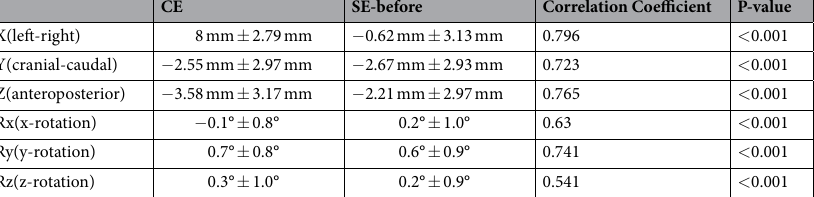
Table 1. Correlation studies of CE and SE-before. CE: cone beam CT errors; SE-before: sentinel errors before the treatment couch